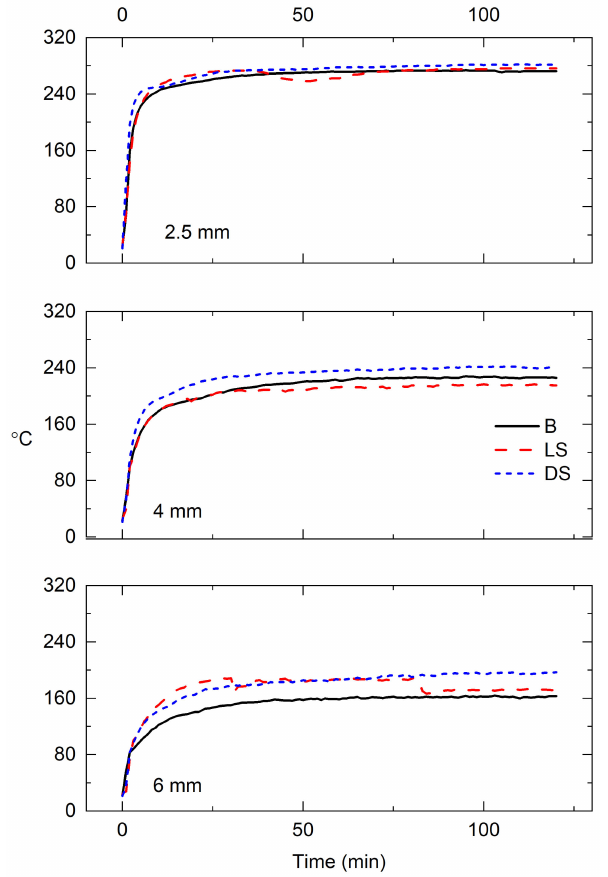
Figure 1. Temperature development within samples measured at 2.5, 4 and 6 mm from surface (average of two measurements per wood type). B = birch, LS = light spruce, DS = dense spruce.